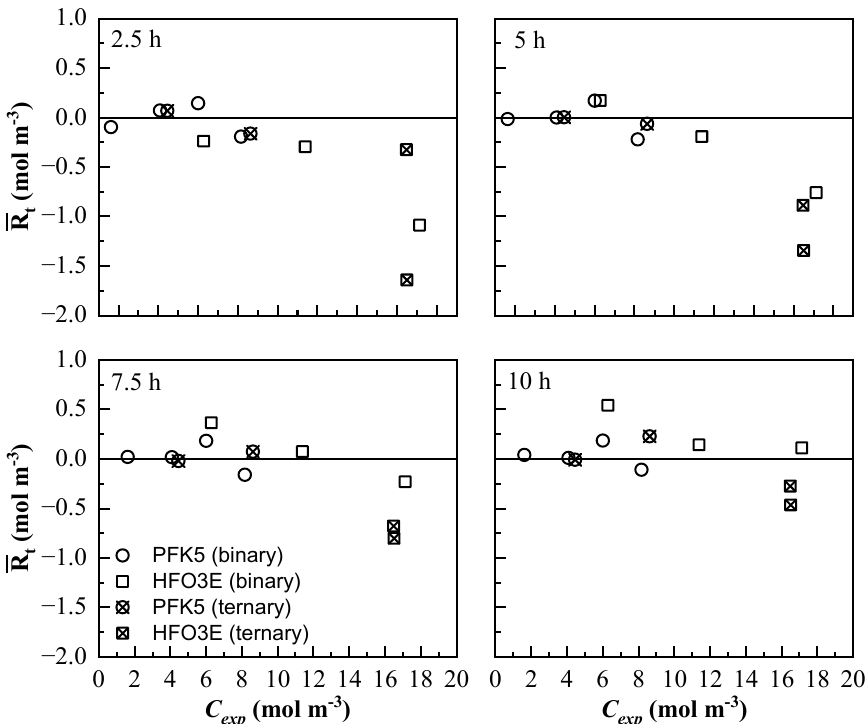
Figure 10. Mean residual value of all measurement lines at different times ( R t ) of the mixing process. The results of all the binary ( and (cid:3) ) and ternary ( ⊗ and (cid:2) ) mixtures are represented for PFK5 and HFO3E, respectively.